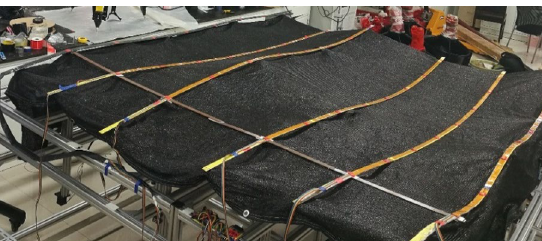
Fig. 12 Shape #1 of the terrain